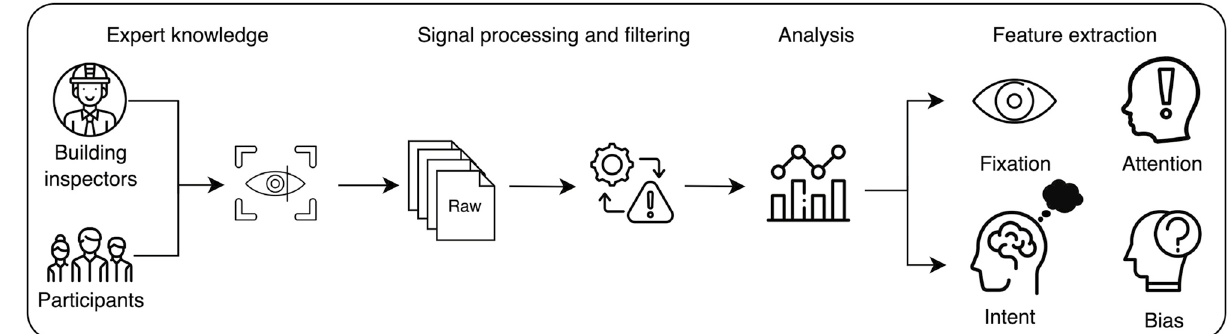
Figure 1. An overall framework for Eye tracking based infrastructure